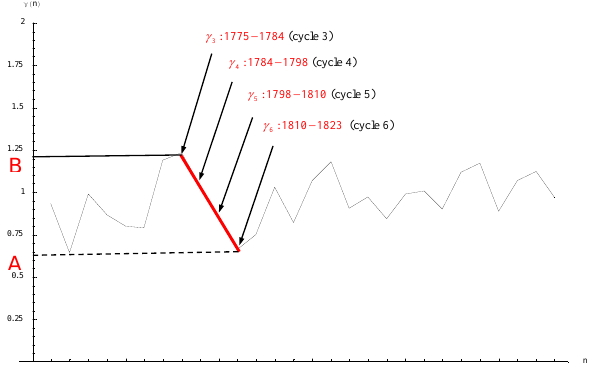
Fig. 10. Plot of to the Z¨urich cycle numbers.